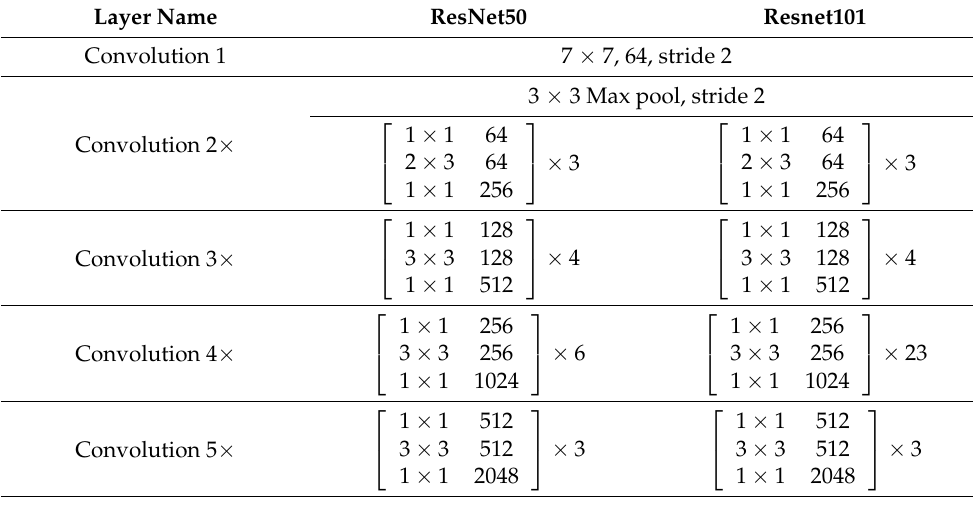
Table 1. Differences between ResNet50 and ResNet101